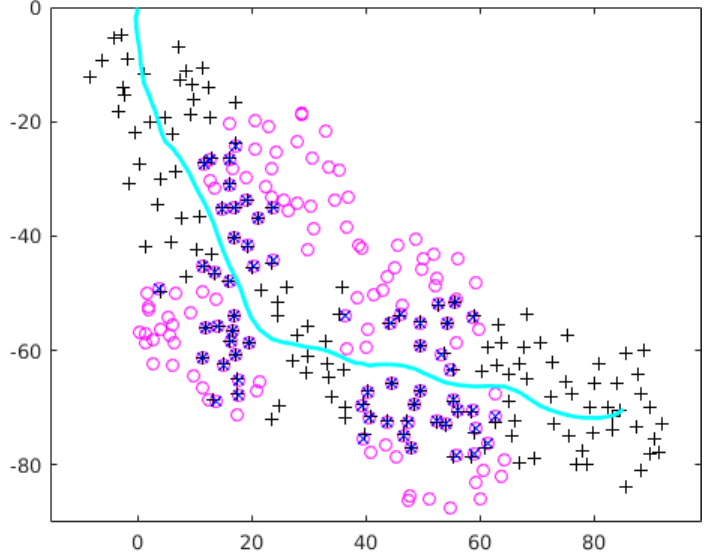
Figure 20. Sonstorp 2. Map over detected trees (black ‘+’), field measured trees (magenta ‘o’) and linked trees (black ‘+’ + magenta ‘o’ + blue ‘x’). The cyan line shows the vehicle trajectory, starting in [ 0,0 ]